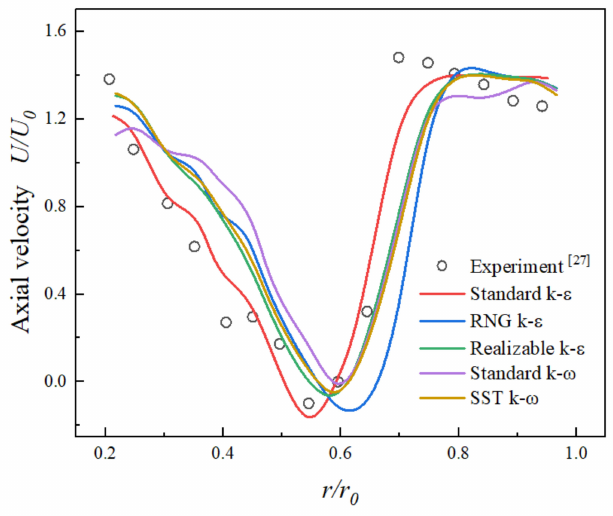
Figure 5. Comparison of axial velocity distribution between experimental result and CFD